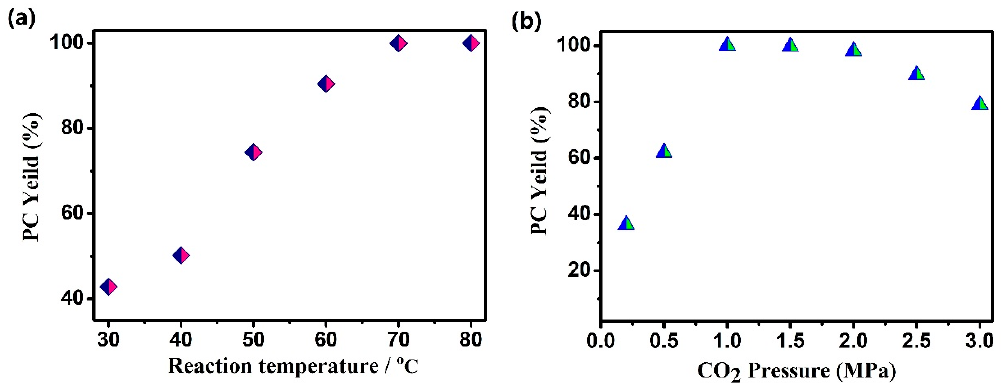
Figure 8. Influence of ( a ) reaction temperature ( P (CO 2 ) = 1.0 MPa, t = 12 h), and ( b ) CO 2 pressure ( T = 70 °C, t = 12 h) on the cyclo-addition of CO 2 with PO. Other reaction conditions: PO (20 mmol); compound 2 (2 mol%); n -Bu 4 NBr (2.5 mol%).